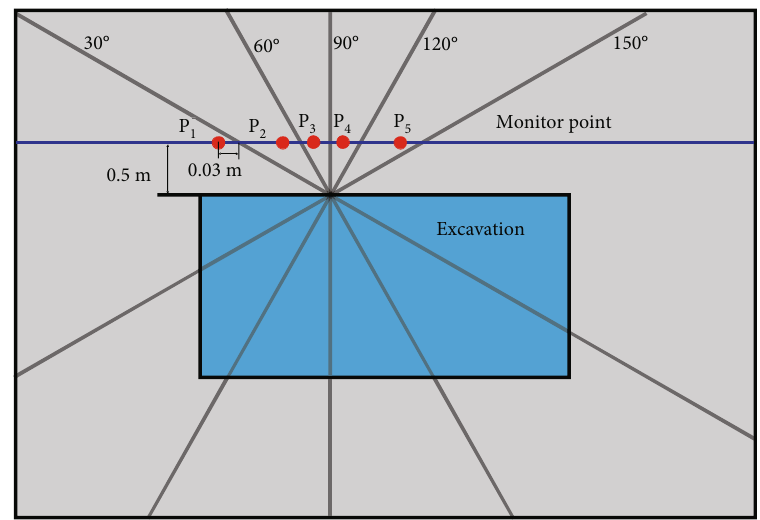
Figure 18: Schematic diagram of discontinuity angle arrangement and monitoring point distribution.